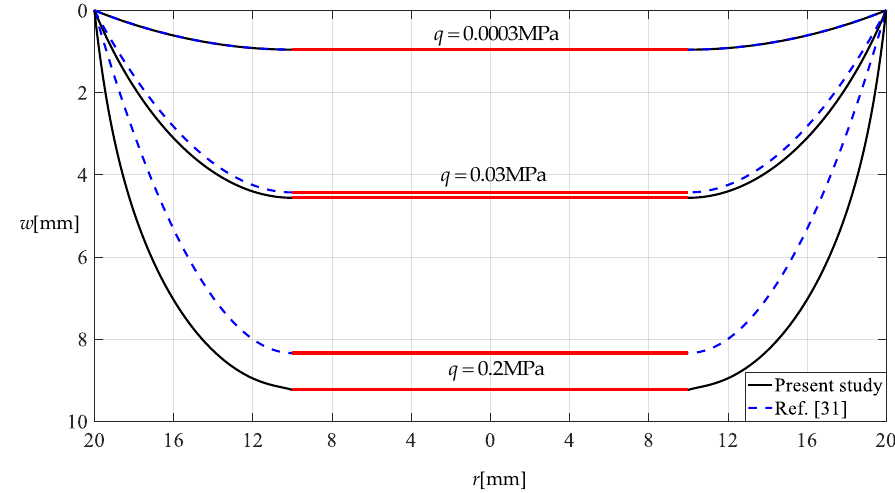
Figure 12. Variation of deflection difference with load q .